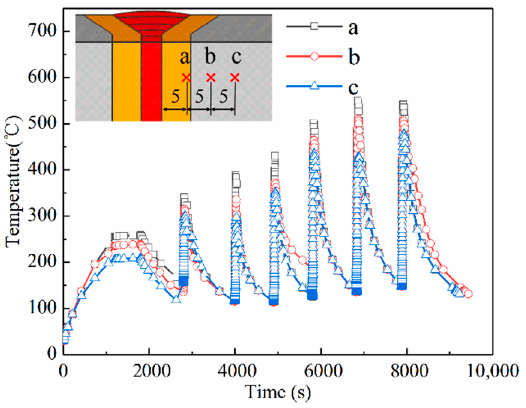
Figure 7. Welding thermal cycle curves obtained from finite element analysis.